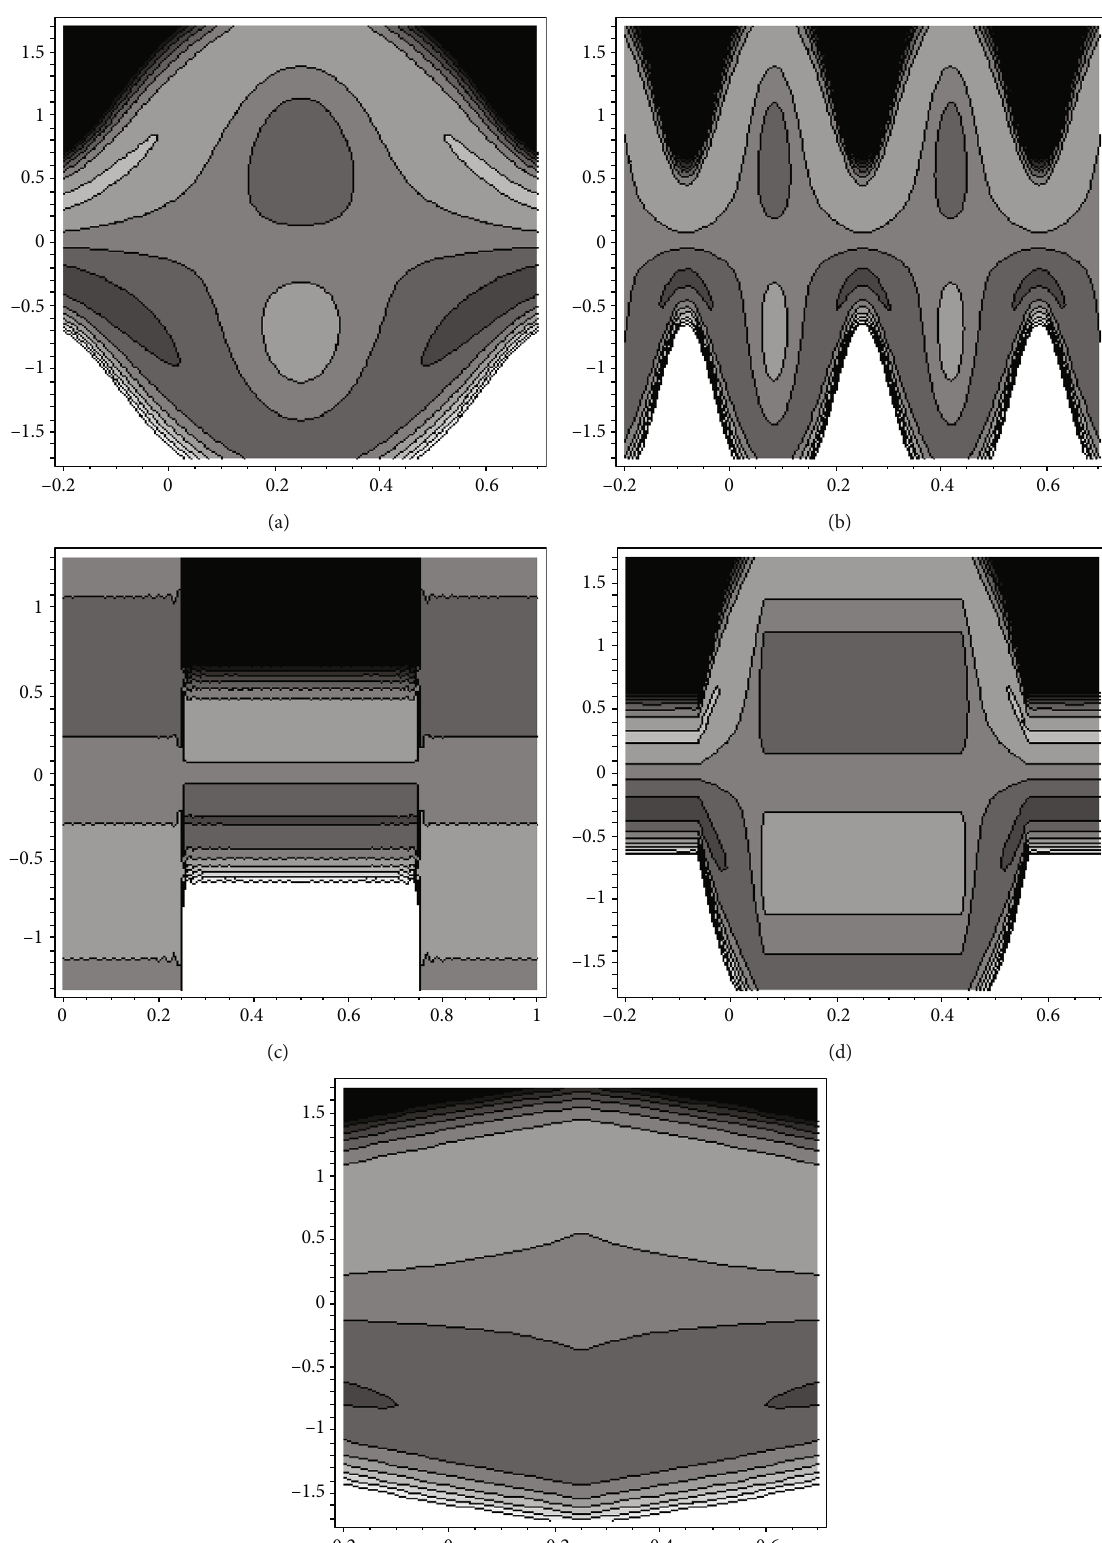
Figure 24: Stream lines for di ff erent wave forms (a) for the sinusoidal wave, (b) for the multisinsoidal wave, (c) for the square wave, (d) for the trapezoidal wave, and (e) for the triangular wave. The other parameters are n = − 0 : 8 , β = 6 , φ = 0 : 7 , y = 1 , We = 0 : 53 , and Q = 3 : 3